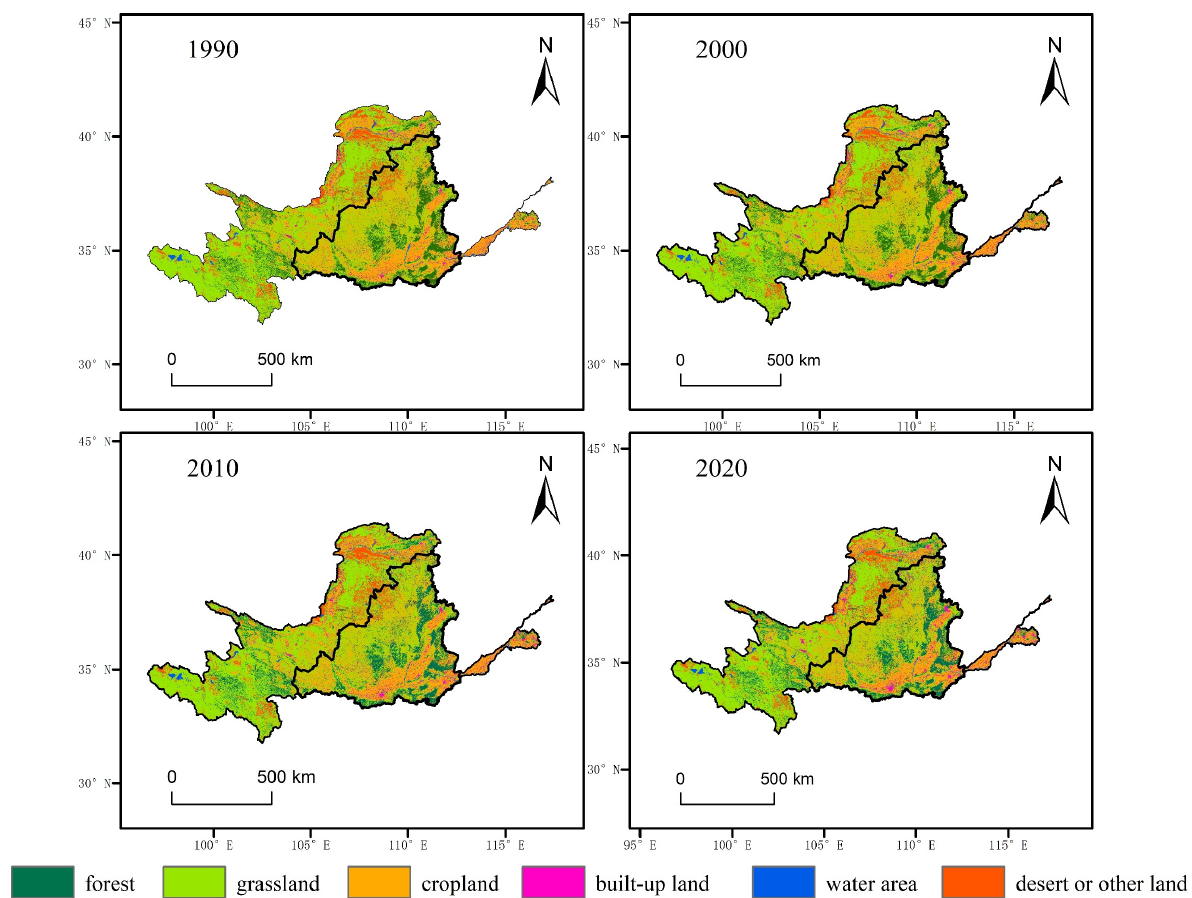
Figure 2. Spatial distribution of land cover in the YRB area during the period from 1990 to 2020.